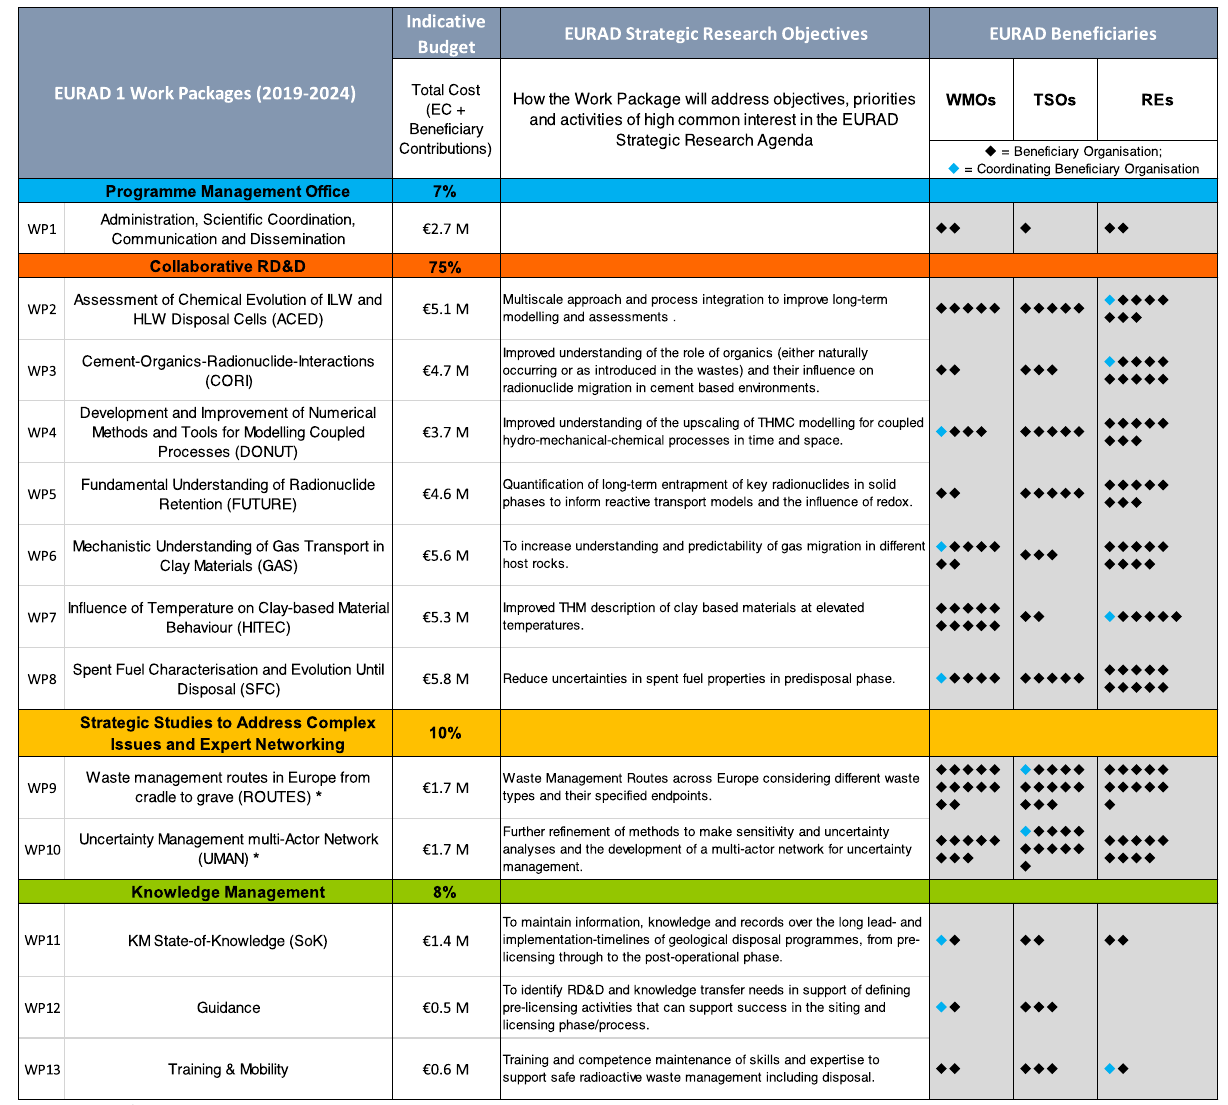
Fig. 3. EURAD fi rst implementation phase (2019 –